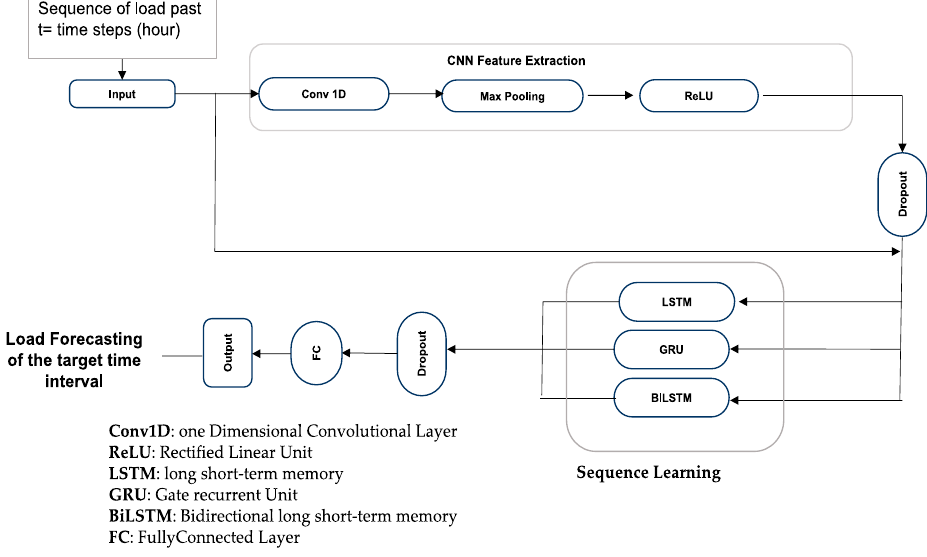
Figure 8. Proposed hybrid DL algorithm architecture for 1-D CNN combined with different DL al- gorithms.